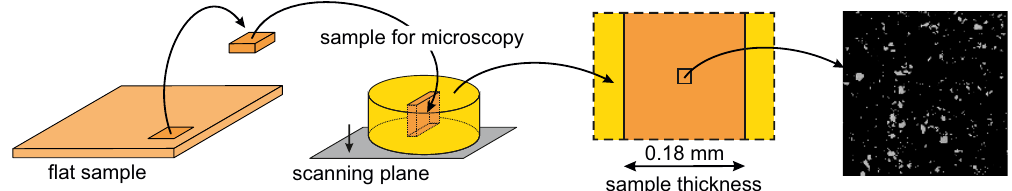
Figure 1. Graphical schema showing the sample preparation for SEM